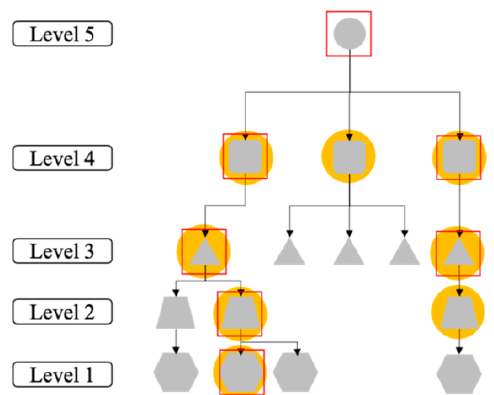
Figure 6. Object recognition using the hierarchy of